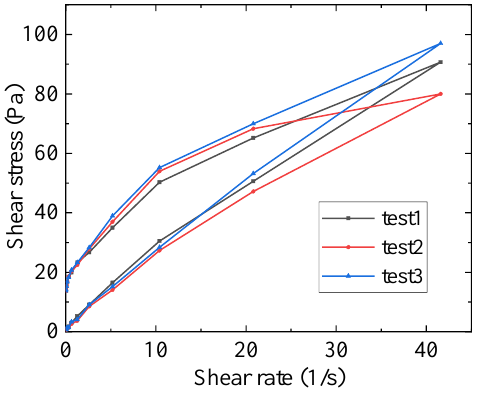
Figure A3. Hysteresis loop experiment results.